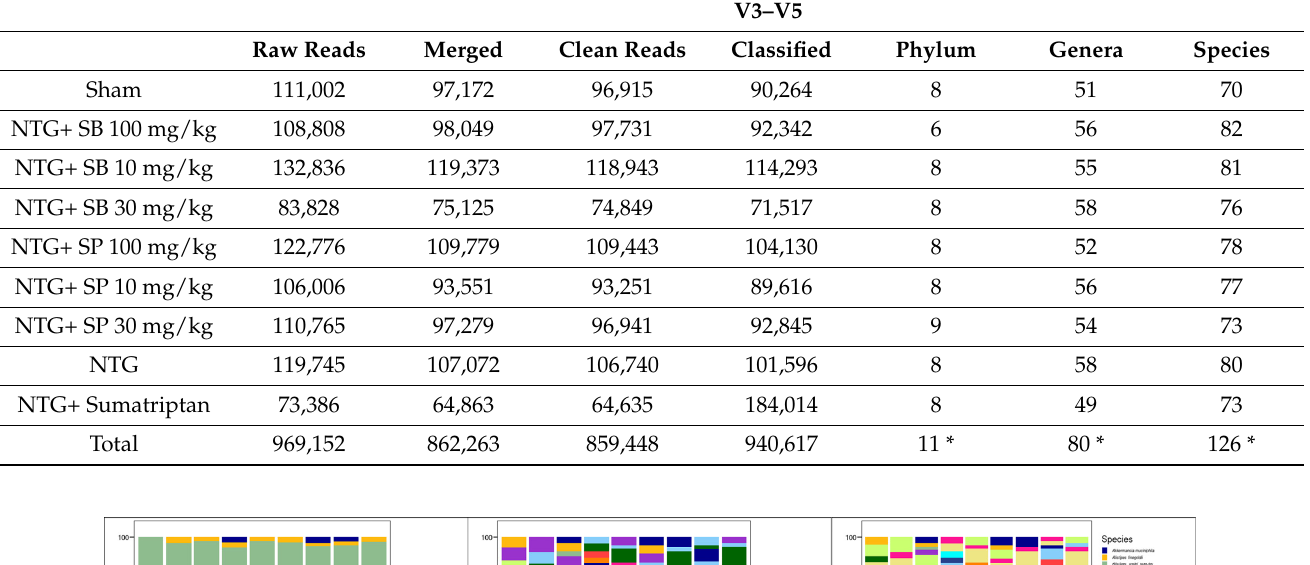
Table 1. Bioinformatic metrics and number of Taxa identified. Marked with dash the number of unique taxa found through the samples. V3–V5